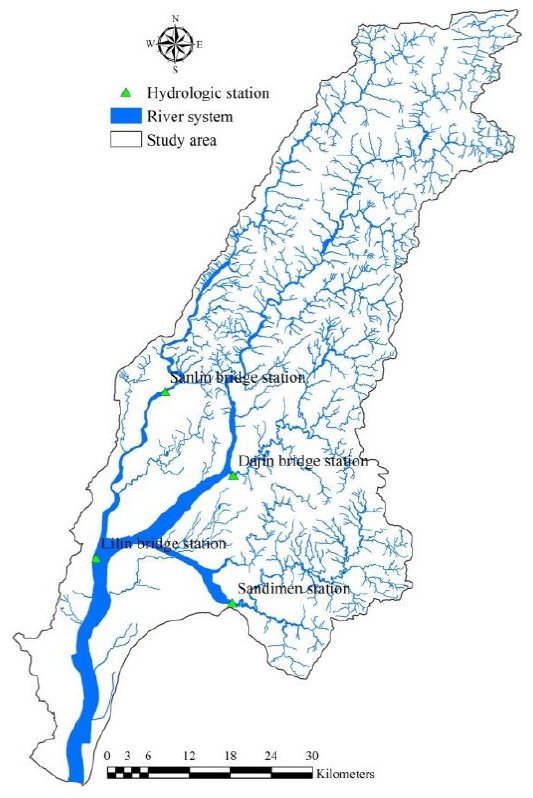
Figure 10. Sediment monitoring stations on the Gaoping River and its tributaries.